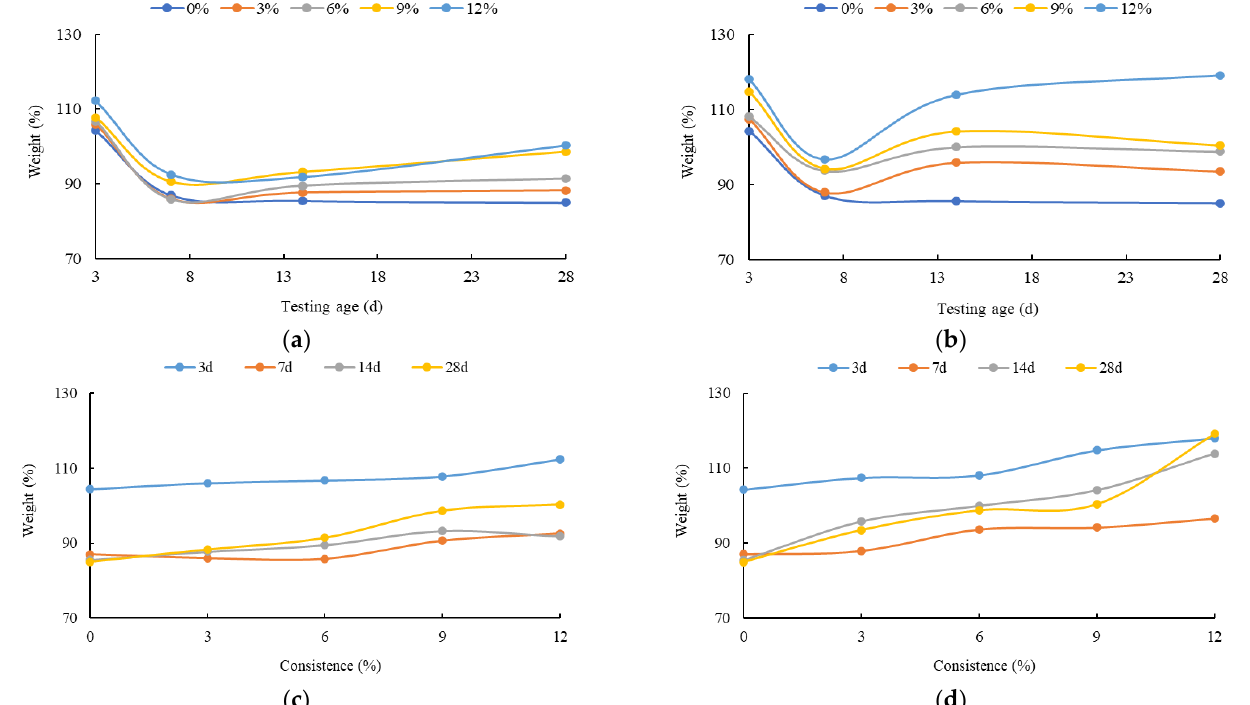
Figure 11. Changes in the peak area of hydration products in the second stage of endothermic peak: ( a ) IN; ( b ) OU; ( c ) IN; ( d ) OU